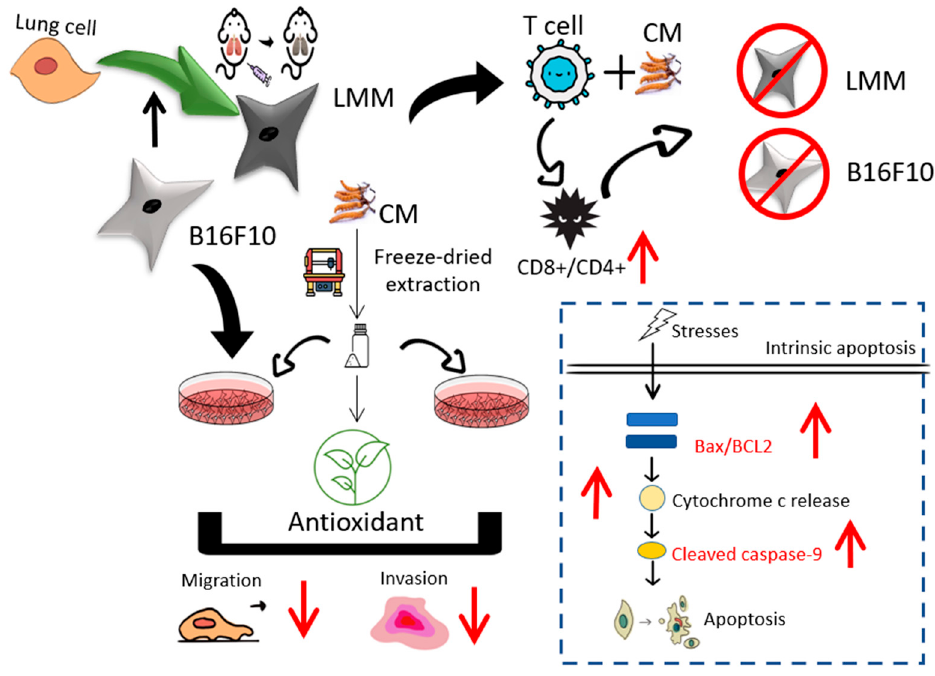
Figure 6. The process and results of this